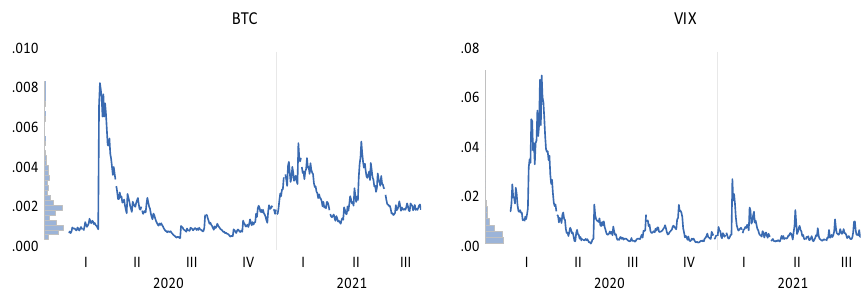
Fig. 2 Conditional variance for EGARCH(1,1). Source Authors’ own work. Notes: Variables’ description